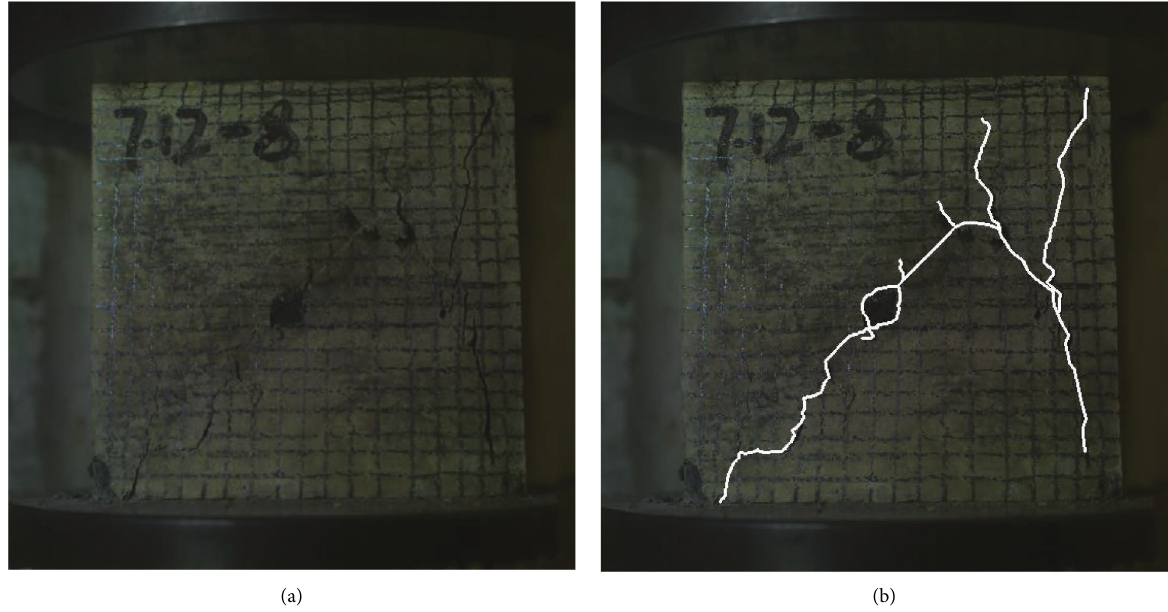
Figure 6: The comparison of the test photo before and after processing: (a) test photo before processing and (b) test photo after